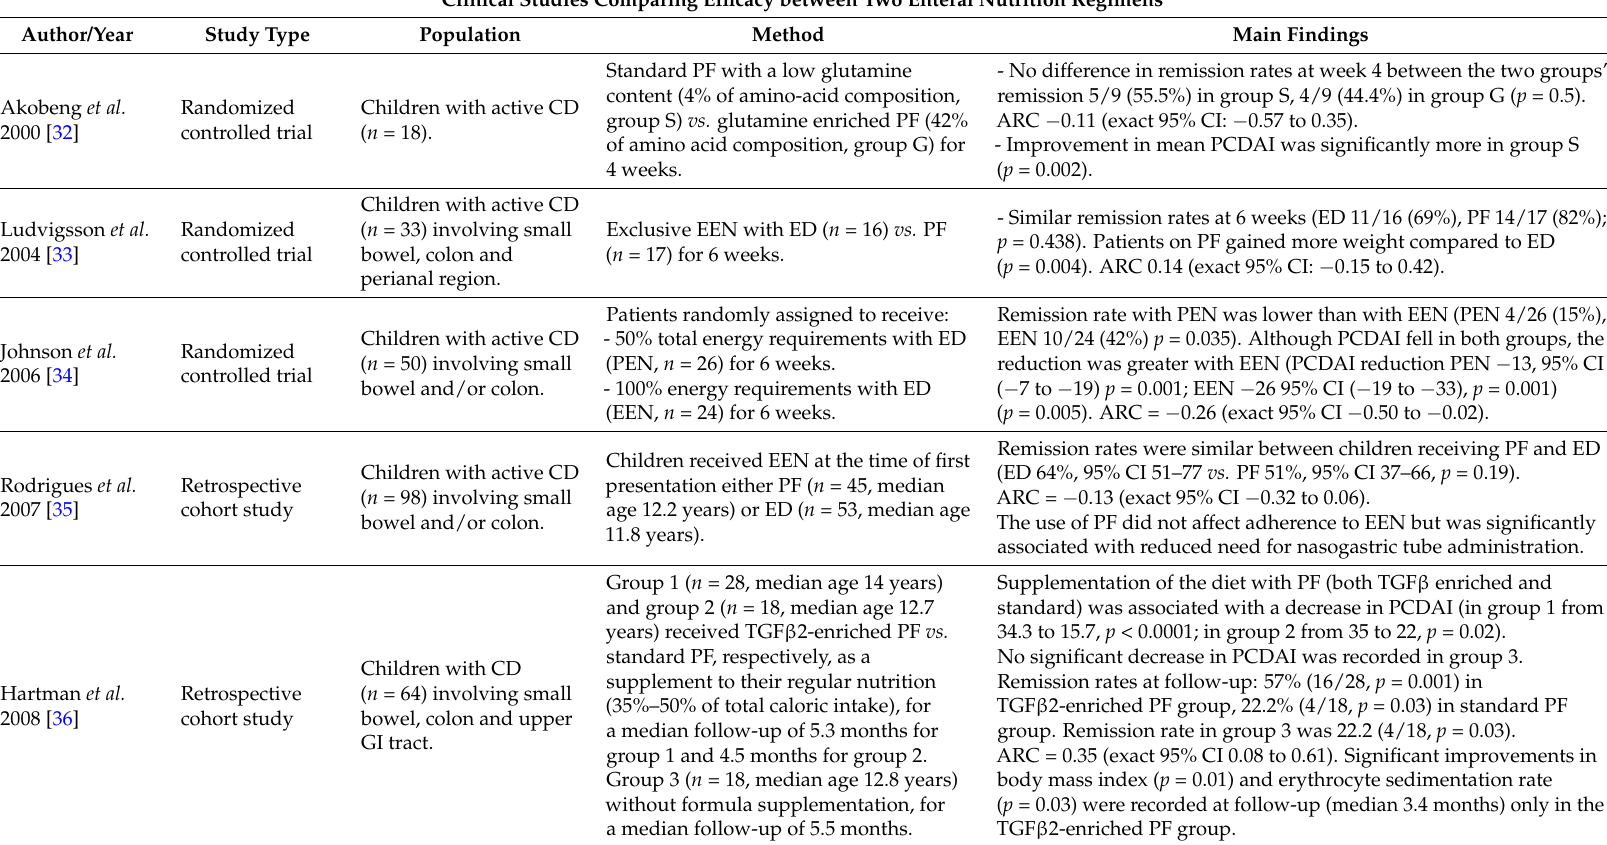
Table 3. Clinical studies comparing efficacy between two enteral nutrition regimens. PCDAI = Pediatric Crohn’s Disease Activity Index, PF = polymeric formula, ED = elemental diet, PEN = partial enteral nutrition, EEN = exclusive enteral nutrition, IFX = infliximab, anti-TNF = anti-tumor necrosis factor, TGF β 2 = transforming growth factor beta 2, ARC = absolute risk